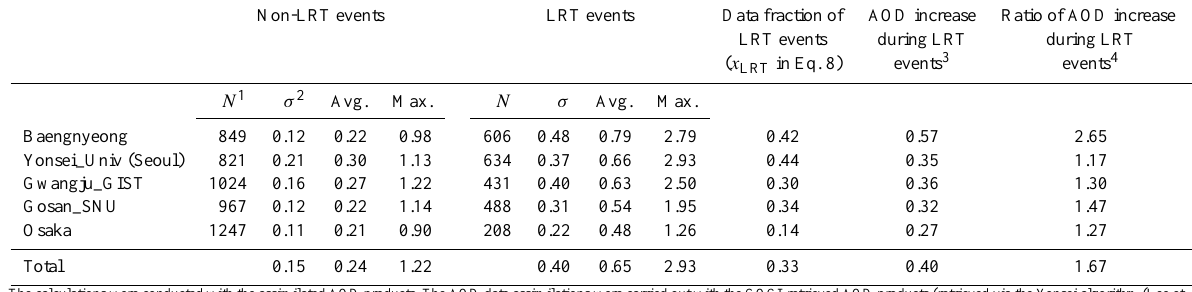
Table 4. Comparison analysis of the assimilated AOD for LRT and non-LRT events at five AERONET sites during the entire modeling period of 1 April to 31 May 2011. Non-LRT events LRT events Data fraction of AOD increase Ratio of AOD increase LRT events during LRT during LRT ( x LRT in Eq. 8) events 3 events 4 N 1 σ